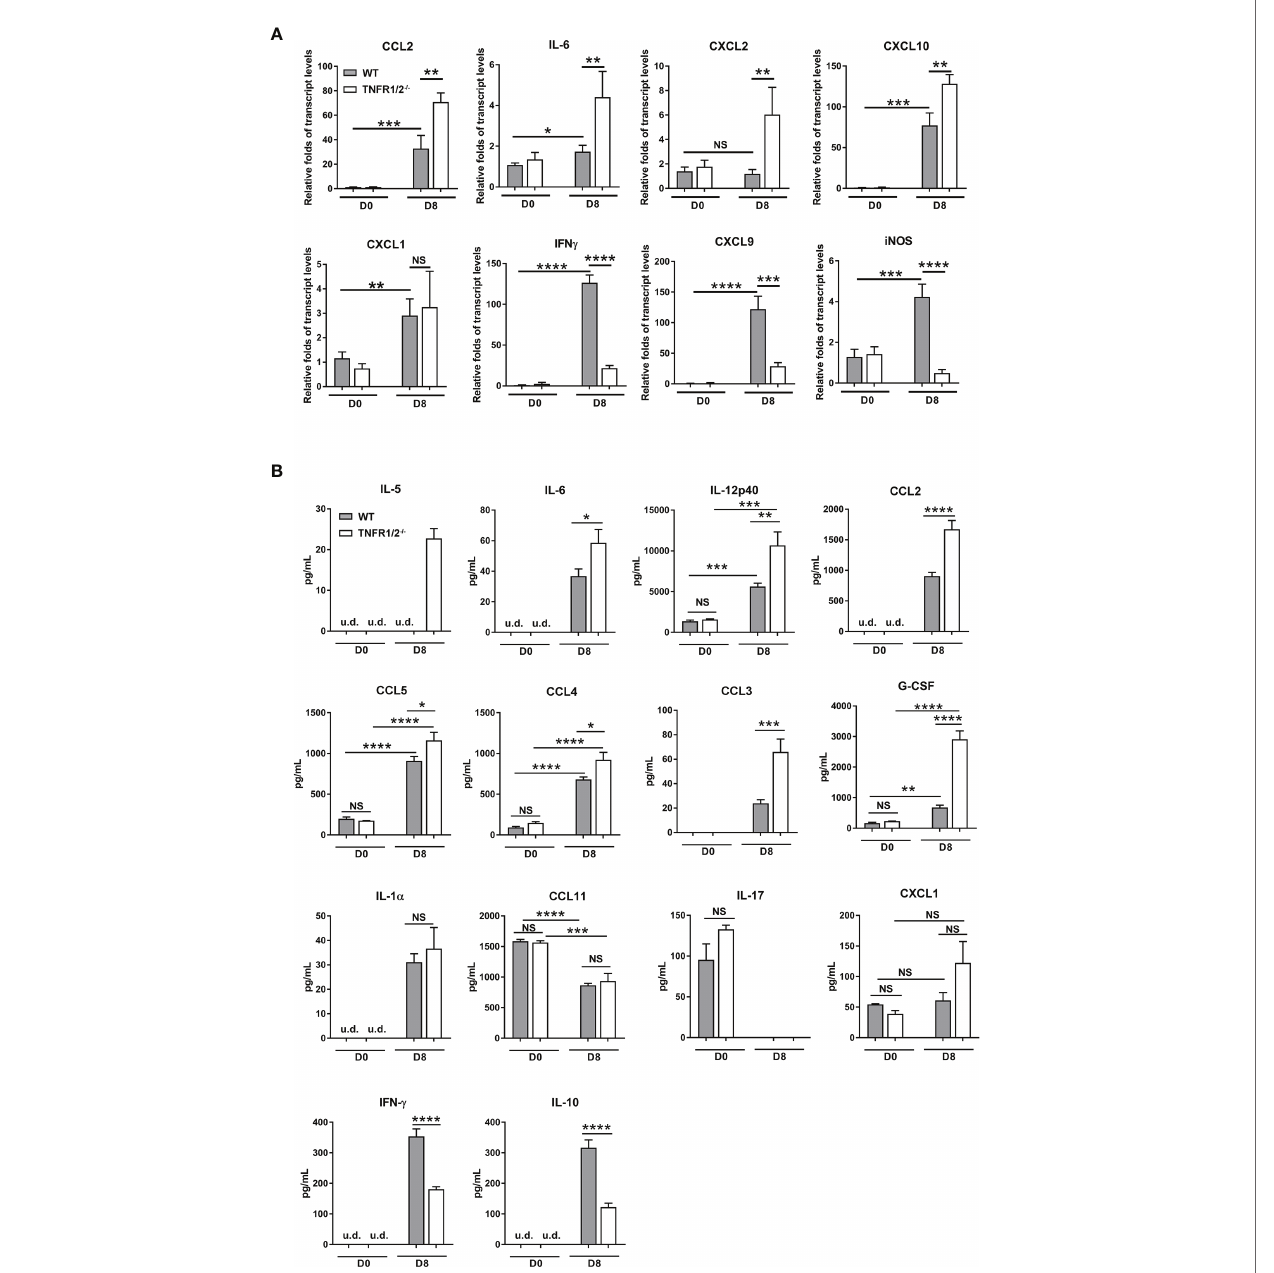
FIGURE 5 | De fi ciency of TNFR1/2 resulted in increased in fl ammatory cytokines/chemokines, but decreased IFN- g and IL-10 in infection. Mice were infected, as in Figure 2 . Tissues and blood were collected at D8 (4-5 mice/group). (A) qRT-PCR results of immune mediators in the lungs. (B) Bioplex assay of in fl ammatory cytokines in the sera. Data are shown as mean ± SD from single experiments and are representative of two independent experiments performed. A two-tailed student t test was used for comparison of two groups. * p <0.05; ** p <0.01; *** p <0.001; **** p <0.0001; NS, not signi fi